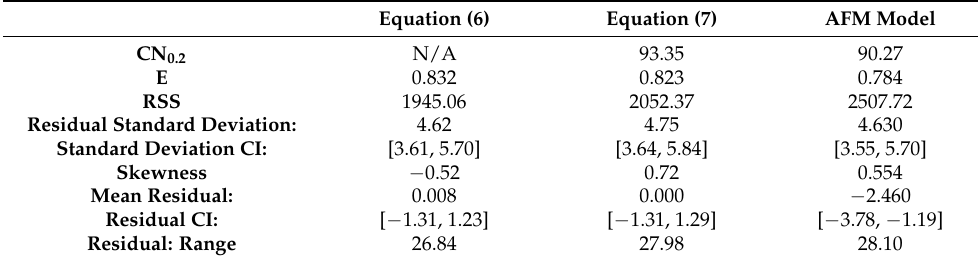
Table 3. Runoff Models’ BCa 99% residual analyses